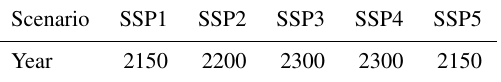
Table 4. Convergence years for IPAT-based convergence downscal- ing for the different